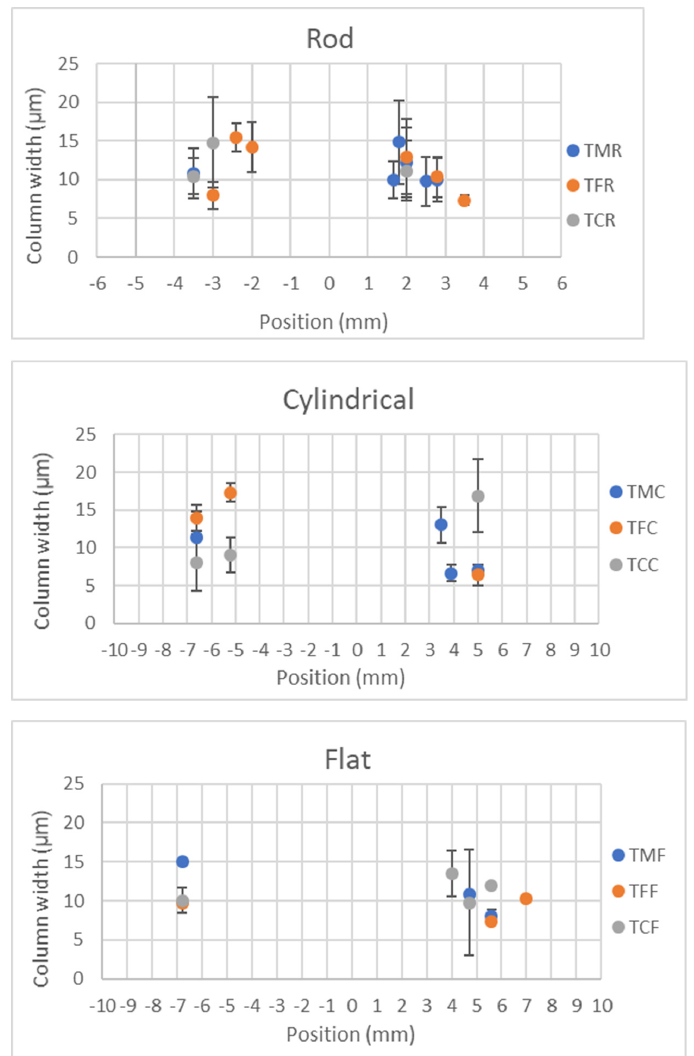
Figure 25. Column width variation along the surface and standard deviation for the ( a ) rod, ( b ) cylindrical and ( c ) flat